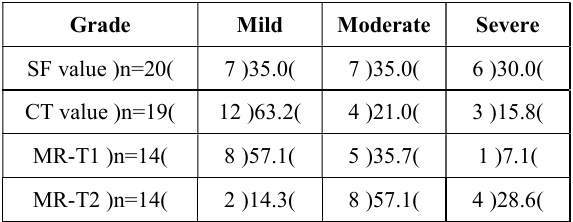
Note: Wilcoxon rank sum test showed no significant